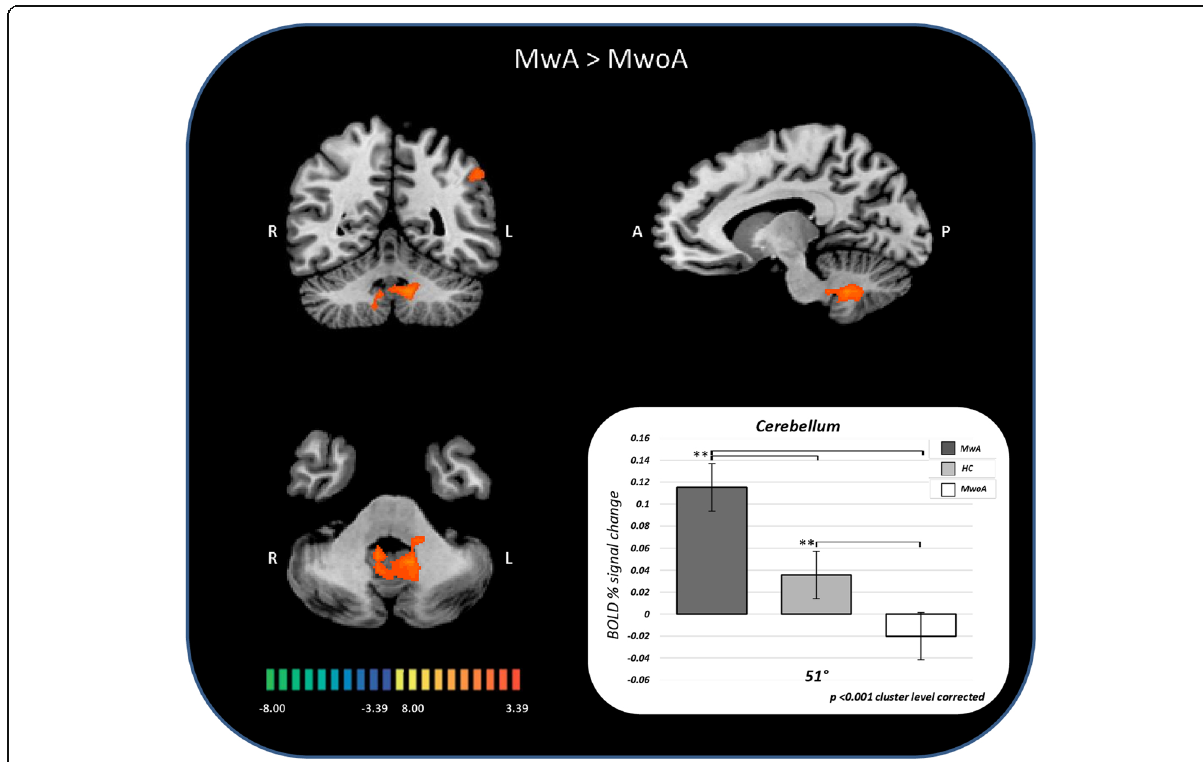
Fig. 3 Percent of BOLD signal change (mean ± SE) at 51 °C from whole brain analysis in group comparisons between patients with MwA, patients with MwoA and HC. SE = standard error; MwA = migraine with aura; MwoA = migraine without aura; HC = healthy controls.